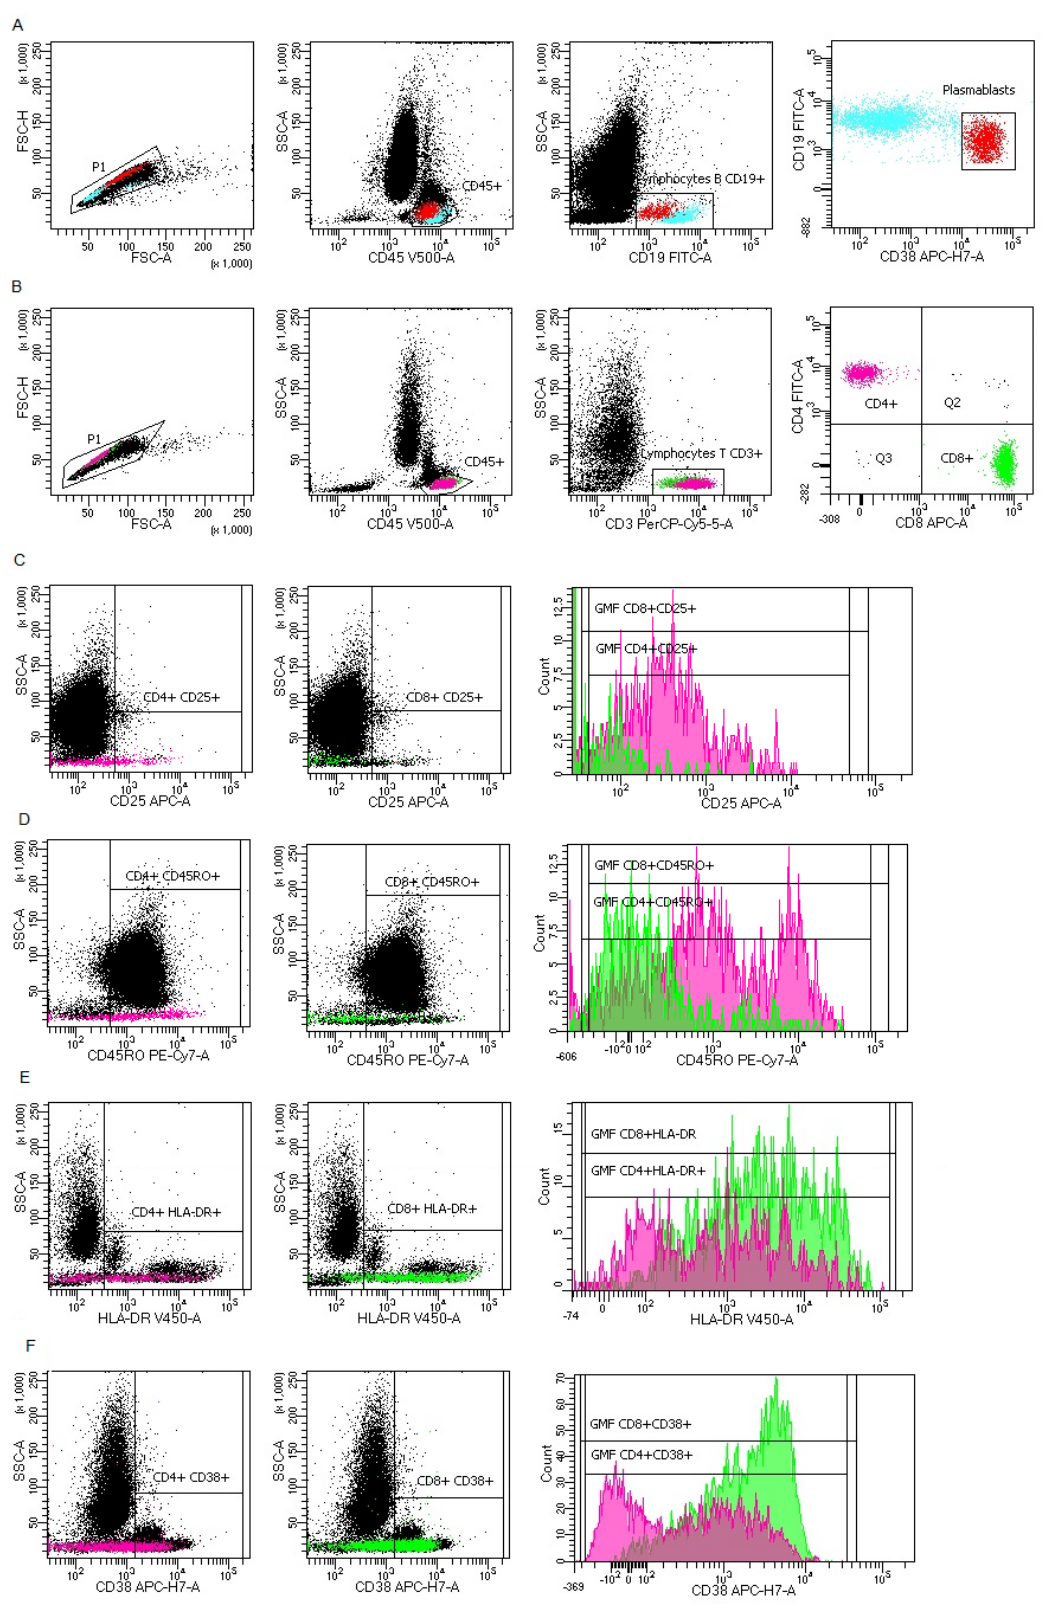
Figure A2. Representative FACS analysis of PB cells with antibodies specific for plasmablasts and T cells (CD4+ and CD8+) with CD25, CD45RO, CD38 or HLA-DR expression. ( A ) Plasmablast gating strategy: FSC-A vs. FSC-H plot: Gating the cells that have an equal area and height, thus removing clumps (greater FSC-A relative to FSC-H) and debris (very low